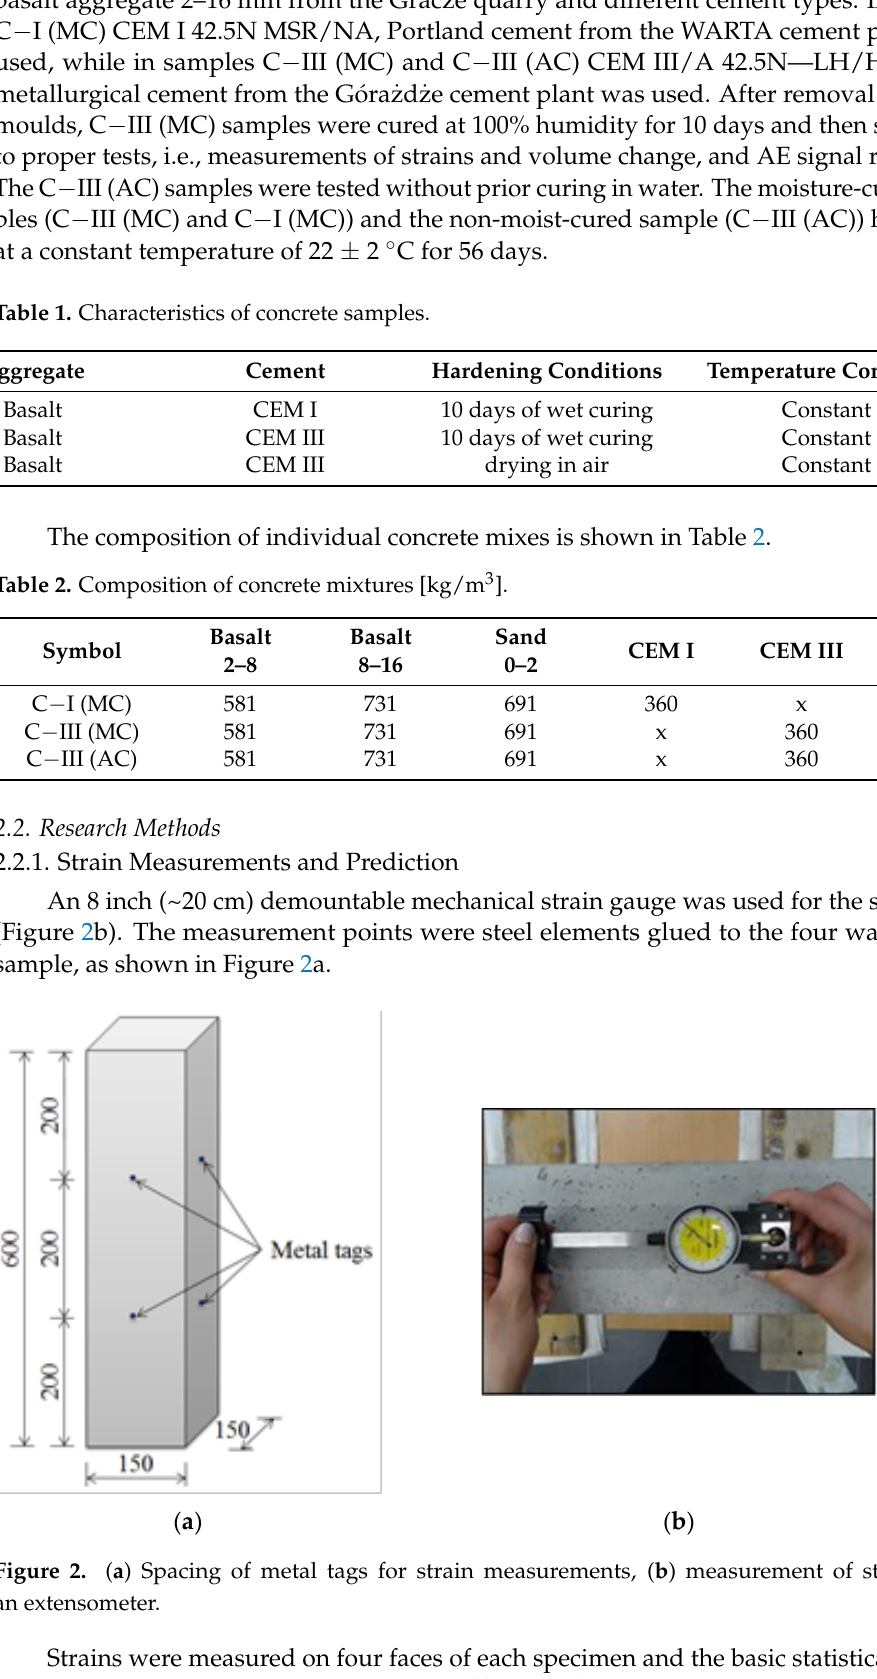
Figure 3. The result of the strain test of specimens from series C − I (MC), C − III (MC), and C − III (AC). The strains (shrinkage) from the tests were compared with the results predicted ac- cording to the following standards: Eurocode 2 (EC2) — PN-EN − 1992 − 1 − 1 [27], Model Code 90 – 99 (MC) [28], and the Bazant-Baweja approach (B3) [29]. The adopted assump- tions are given in Figure 4.